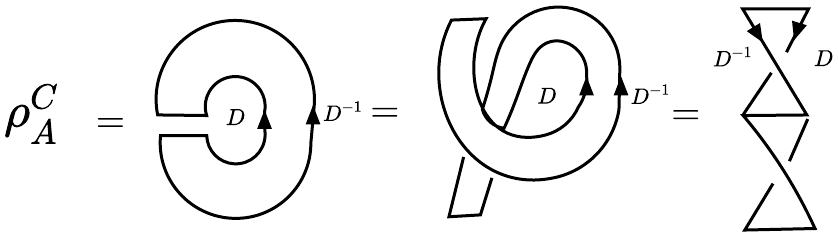
Figure 9 . The reduced density matrix ρ C defined using a noncanonical trace operation fails to A satisfy the E-brane axiom when it is replicated. It also does not commute with the edge mode symmetry